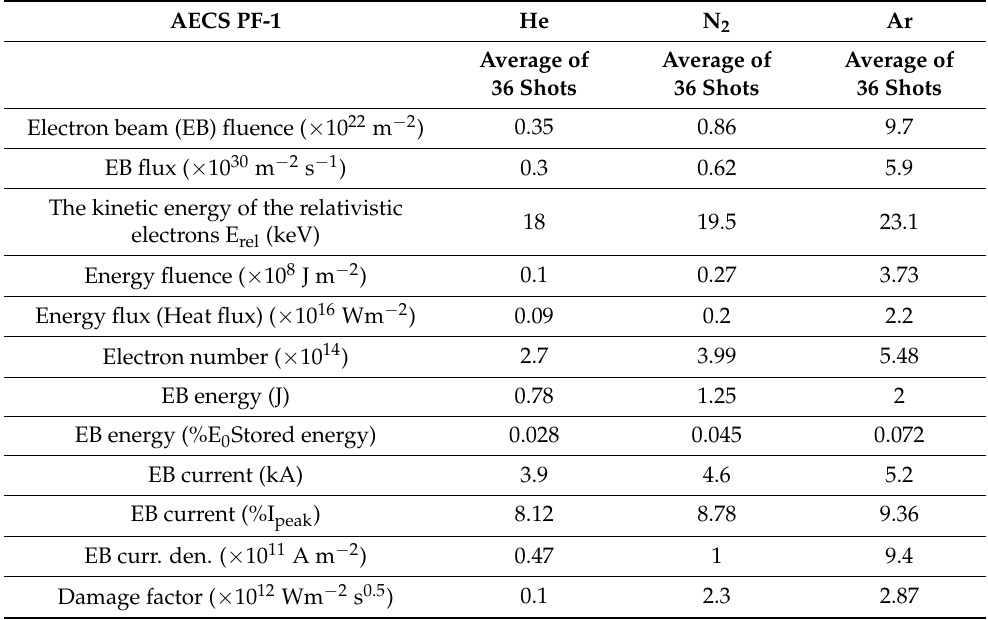
Table 4. Average electron beam characteristics of the AECSPF-1